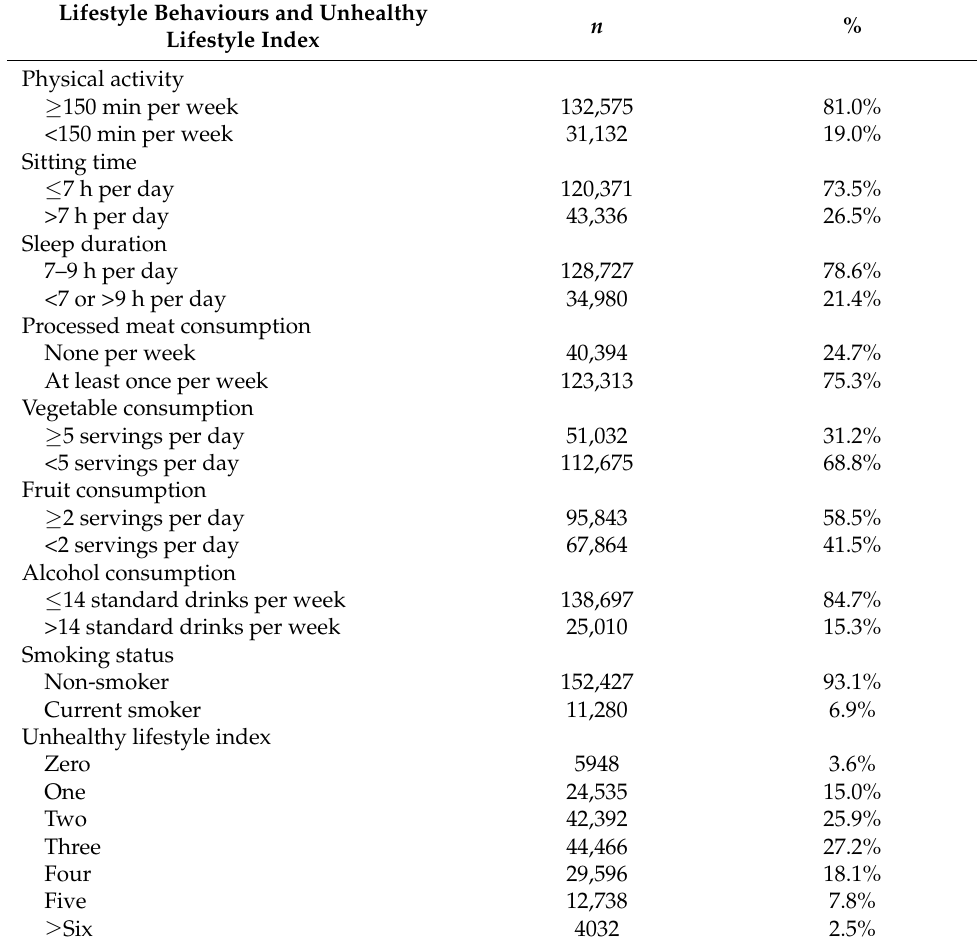
Table 2. Lifestyle behaviours and unhealthy lifestyle index at